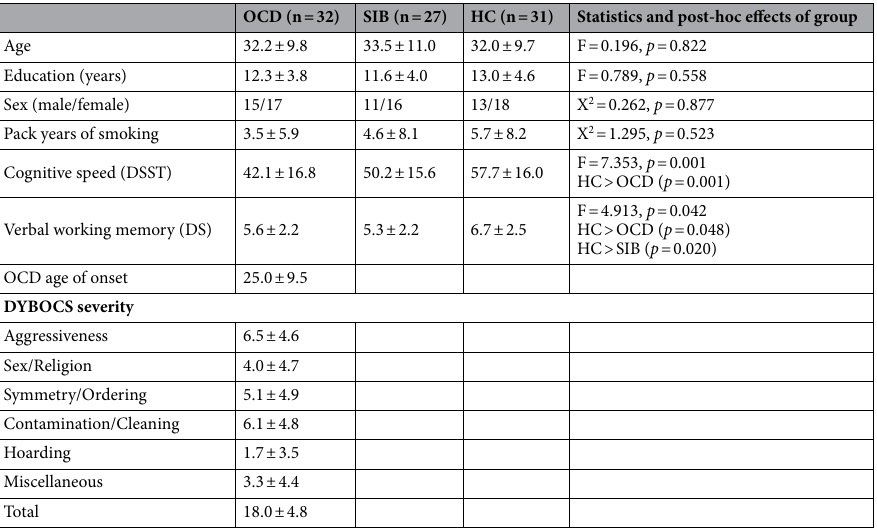
Table 1. Participant sociodemographic and clinical characteristics. Data are presented as mean ± standard deviation. HC healthy controls, OCD patients with obsessive–compulsive disorder, SIB unaffected siblings, DYBOCS dimensional scale for the assessment of the presence and severity of obsessive–compulsive symptoms, DSST Digit Symbol Substitution Test, DS digit span